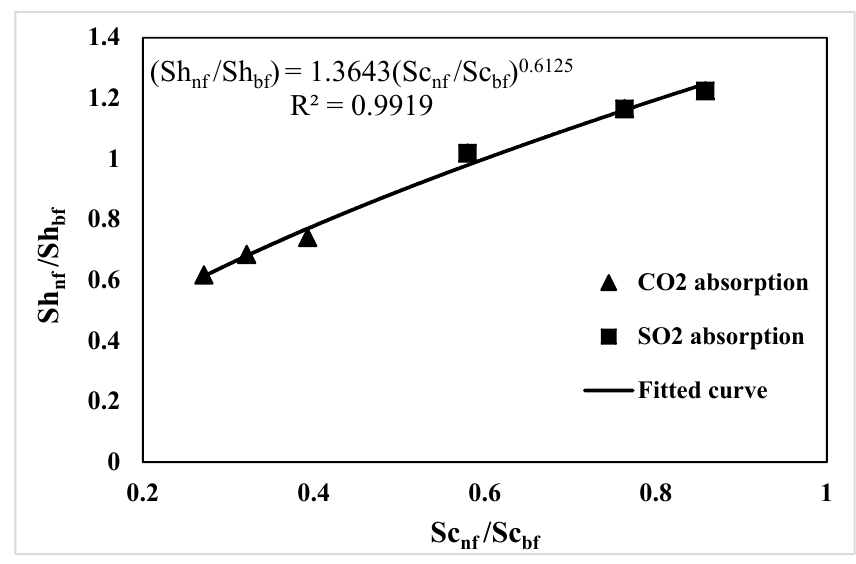
ff ect of relative Schmidt number on relative experimental Sherwood Figure 12. Effect of relative Schmidt number on relative experimental Sherwood number. Figure 12. E